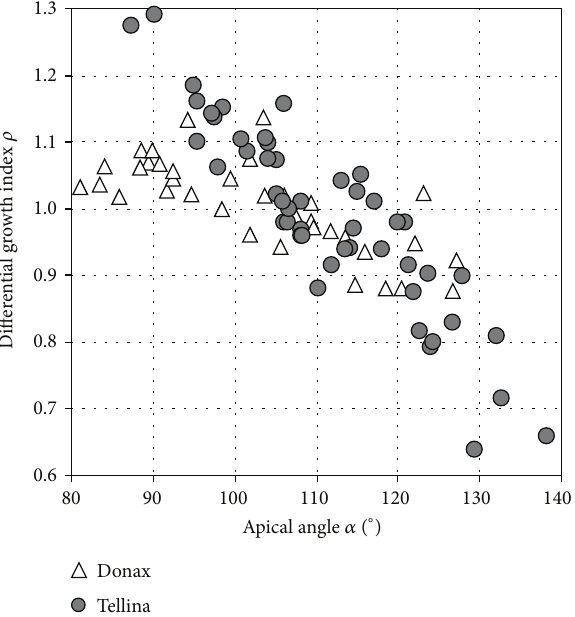
Figure 3: The differential growth index 𝜌 plotted against the apical angle 𝛼 : a strong negative covariance is recorded within each of the two studied bivalves genera, Donax and Tellina . (N.B.: similar patterns of negative covariation between 𝛼 and 𝜌 are observed, as well, within the other, smaller genus belonging to Tellinoidea: Arcopagia, Gari, Macoma ; B´eguinot, unpublished results ).